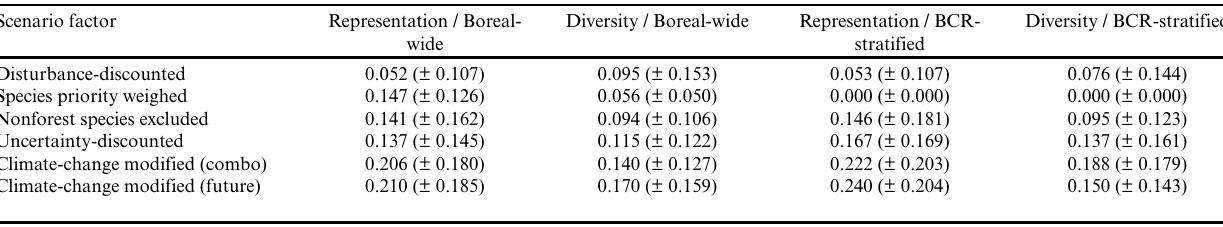
Table 2 . Hierarchical contributions to conservation value of each scenario factor, grouped by prioritization algorithm and stratification. Values represent mean and standard deviation of pixel-level differences in priority ranks ranging from 0 to 1. BCR = bird conservation region.